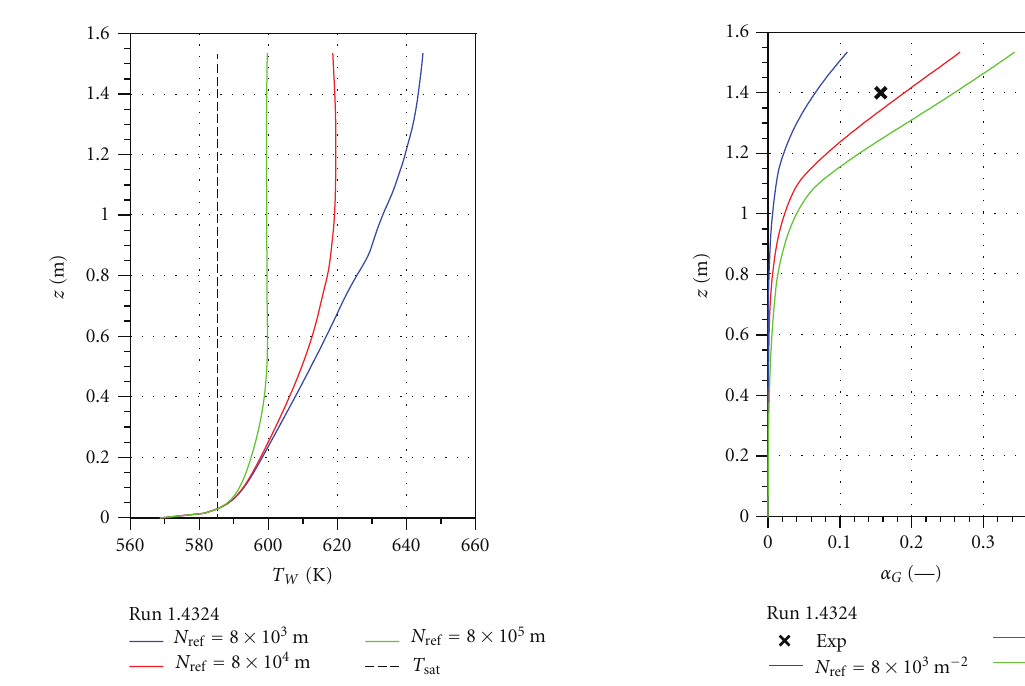
Figure 5: Wall temperature.